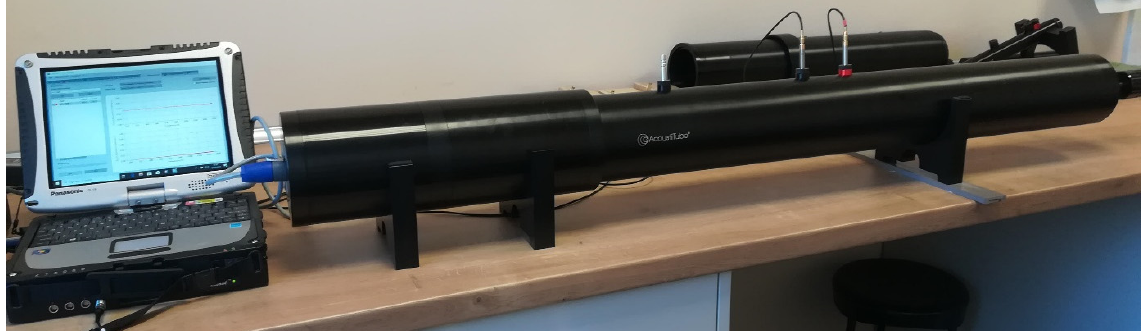
Figure 2. Sound absorption coefficient measurement-impedance tube. Table 2. Measurement variants inside the impedance tube.